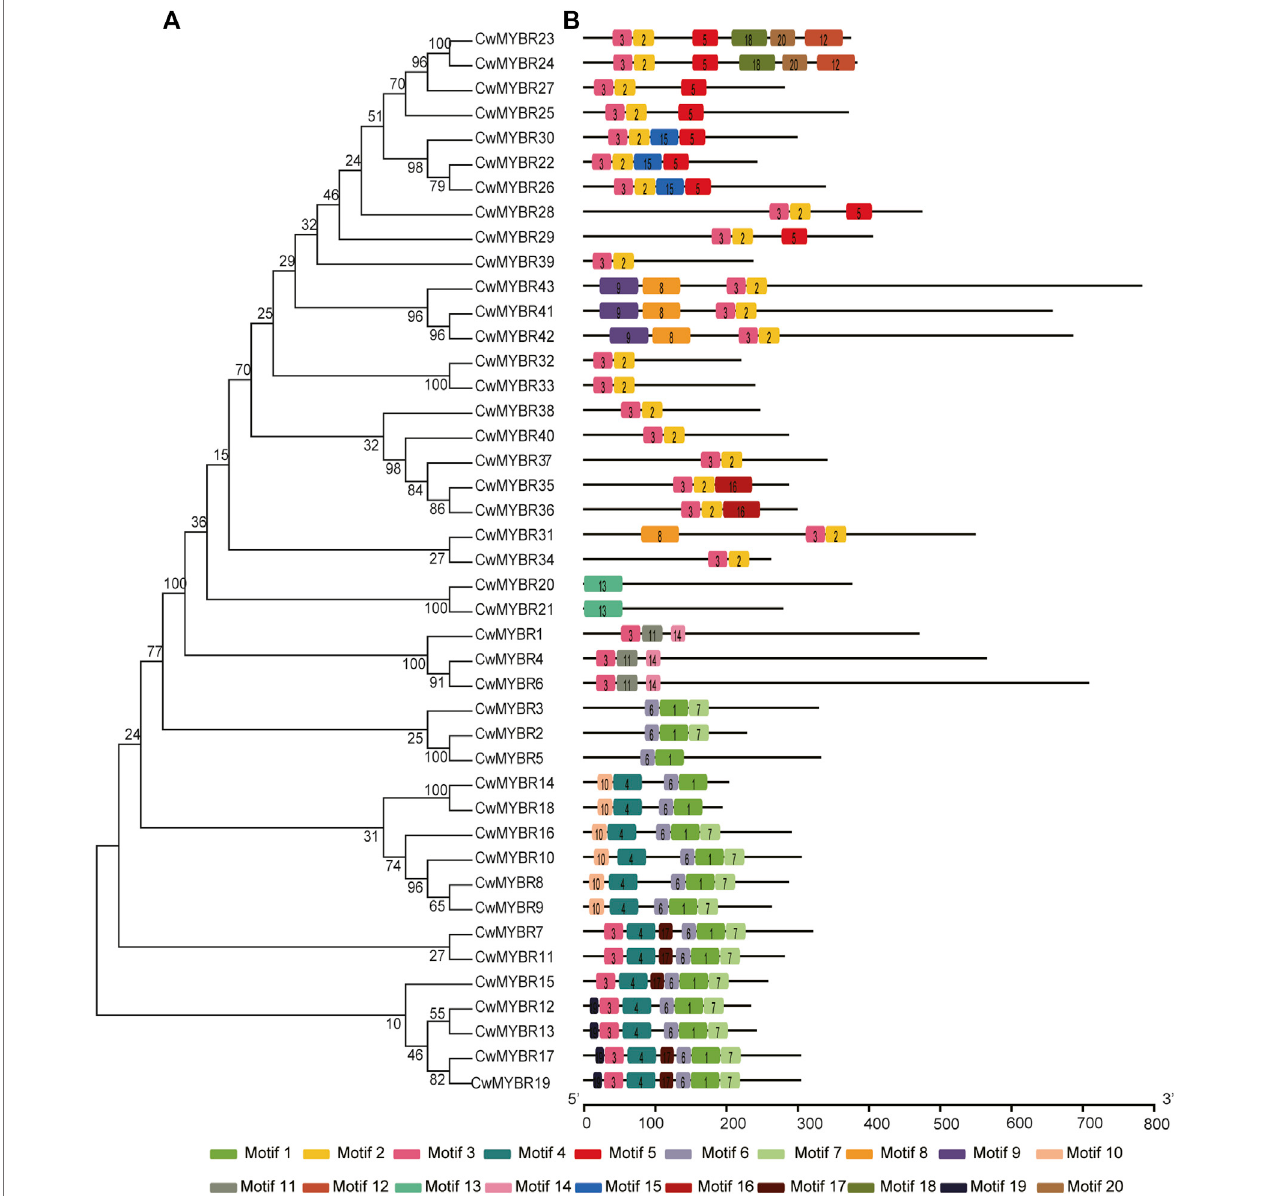
FIGURE4| Phylogenetictreeand motif compositionsofMYB-related proteins in C. wenyujin . (A) Aphylogenetictree of43 MYB-related proteins wasconstructed by using MEGA 7 software coupled with Neighbor-Joining method with a bootstrap of 1,000 replicates. (B) Schematic diagrams of motif compositions. Colored boxes indicate different motifs. The picture was drawn by TB tools